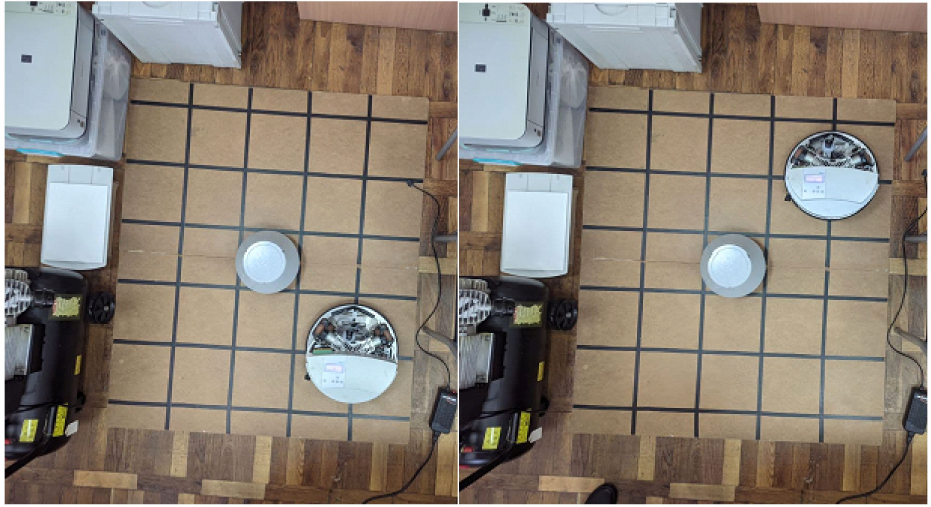
Figure 3. Example of discrete workspace for the Festo